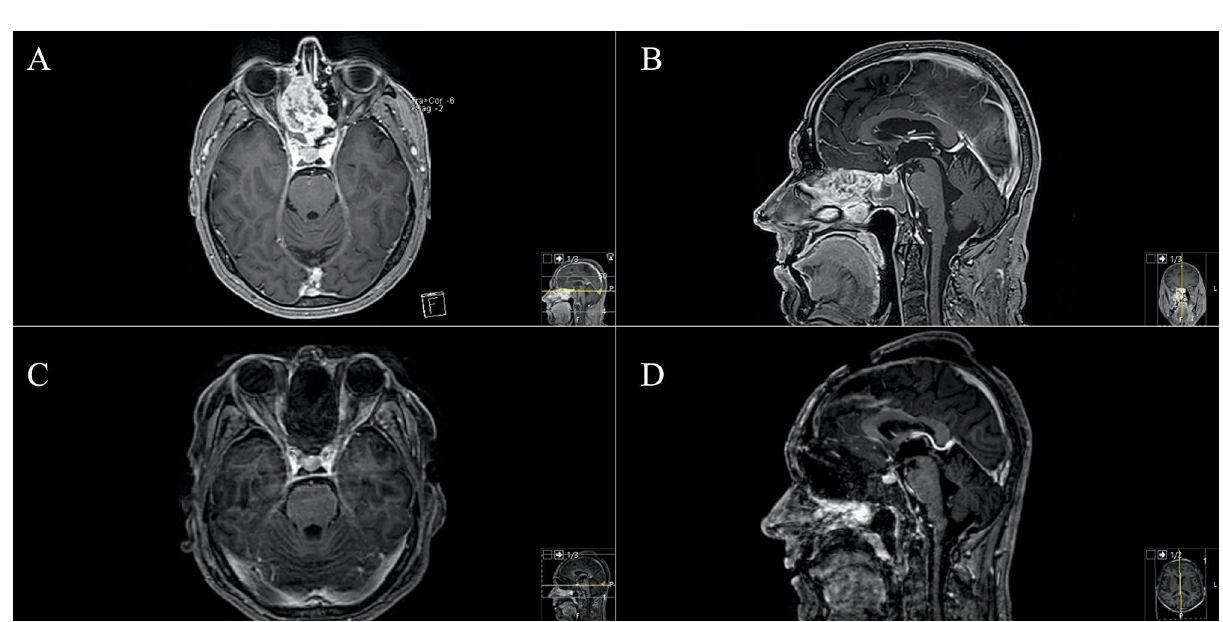
Figure 5. Exemplary case 5: a 64-year-old male patient with anosmia, rhinorrhoea, epiphora and headache. Transnasal biopsy revealed sinusinal intestinal adenocarcinoma. ( A , B ) Preoperative T1-weighted gadolinium- enhanced MR imaging endonasal tumor with transbasal infiltration into sphenoid sinus, cribriform plate and dislocation of right periorbit. ( C , D ) Postoperative MR control showing subtotal resection with questionable tumor remnant at inferior medial orbital wall. Tumor-infiltrated medial orbital walls and orbit roofs were resected. Reconstruction was performed with split-bone graft and galea-periosteum flap. Titan mesh was used as well. A second-step endoscopic procedure was performed for oncological gross total